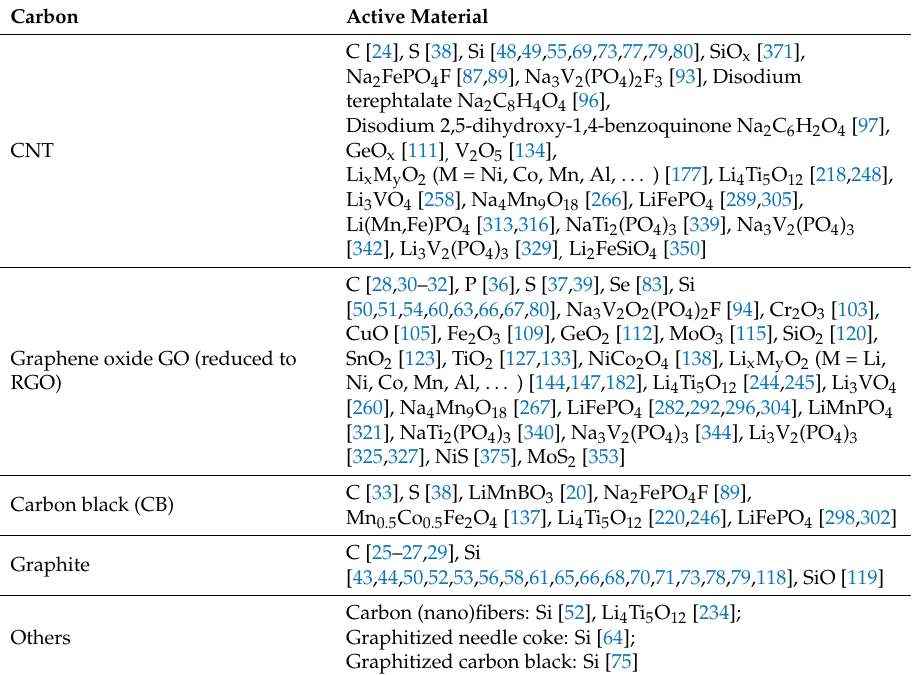
Table 5. Spray-drying synthesis of active material/carbon composites: references to publications where solid conducting carbon or graphene oxide is added to the spray-drying